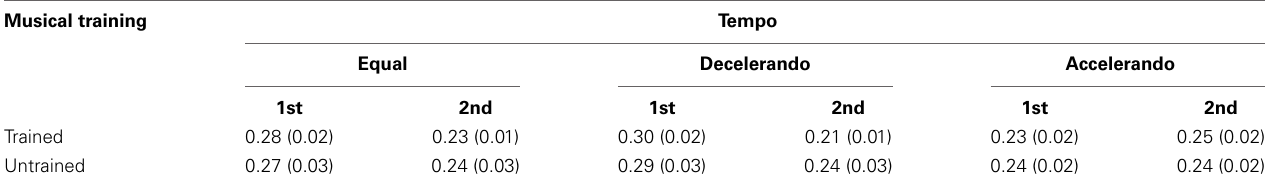
Table 2 | Mean speed of hand movement for the interaction quarter × tempo × training. Musical